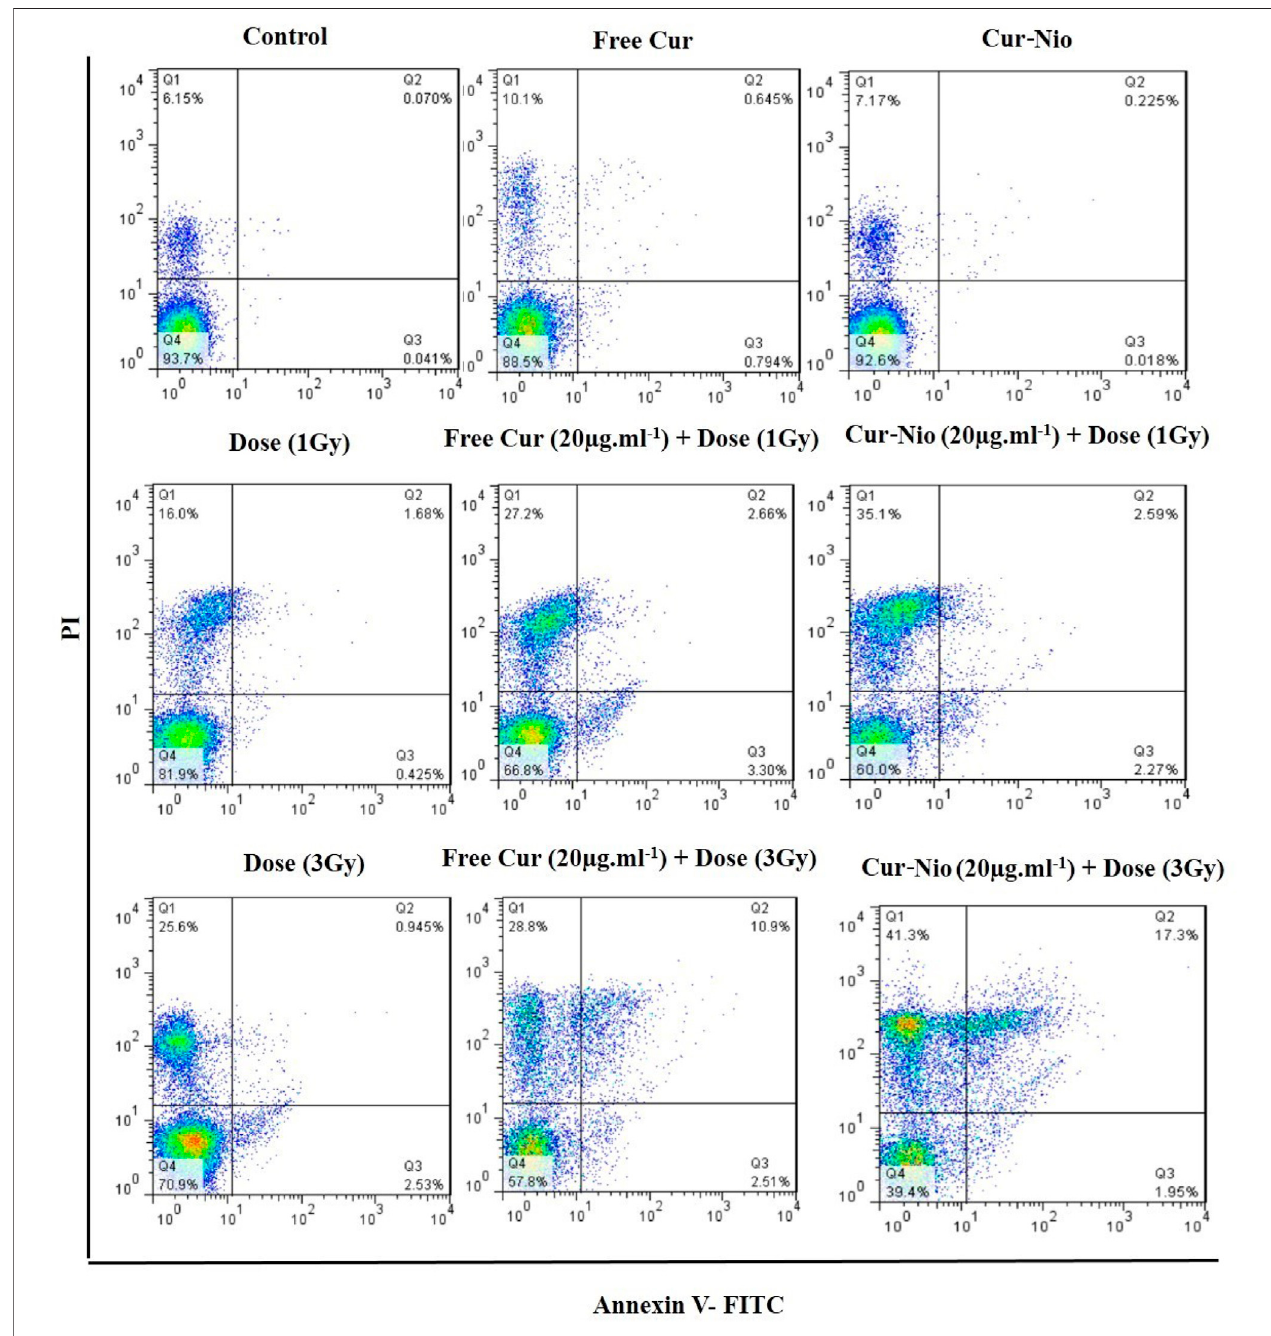
FIGURE 6 | Apoptosis assay using fl ow cytometry, following treatment of cells at 48 h.